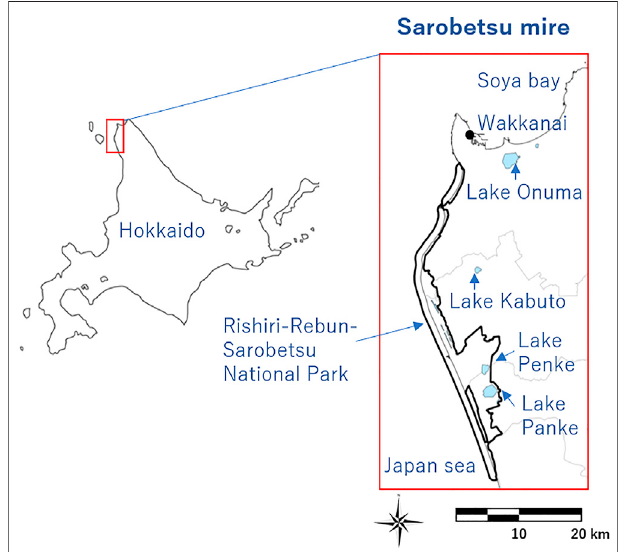
FIGURE 3 | Location of the study area.